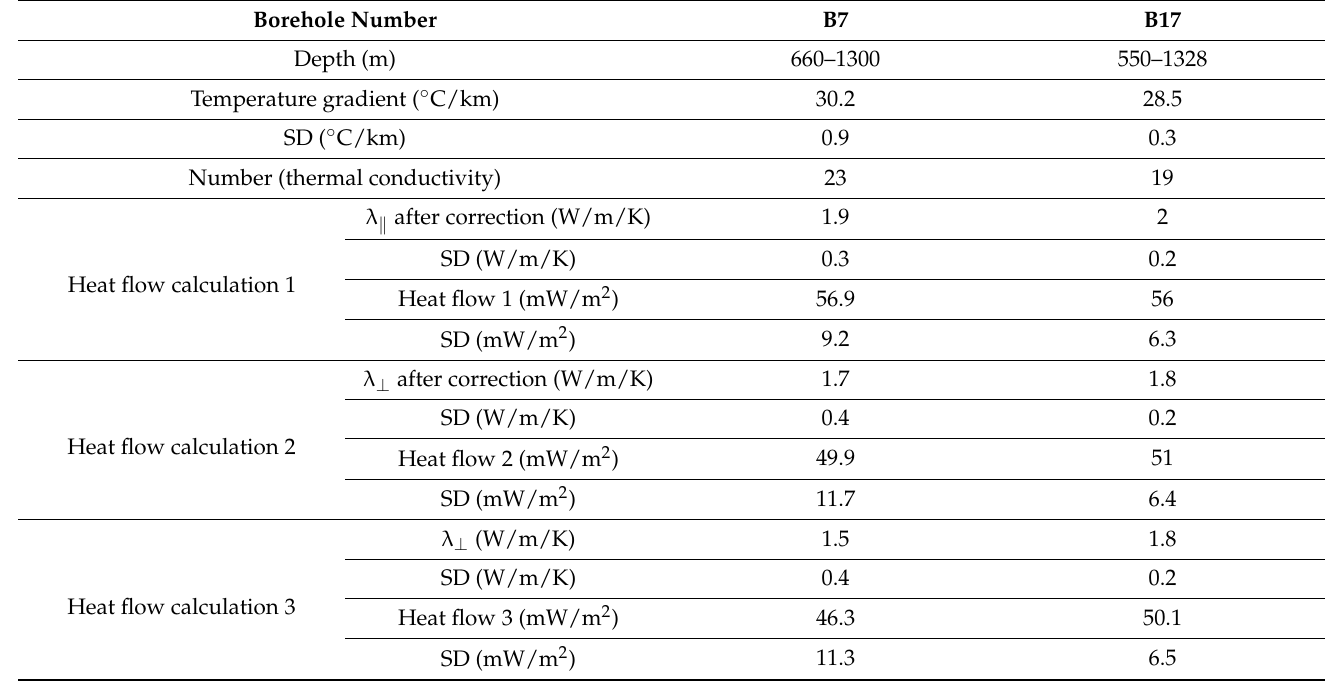
Table 4. Heat flow constrained by different thermal conductivity calculation models. Borehole